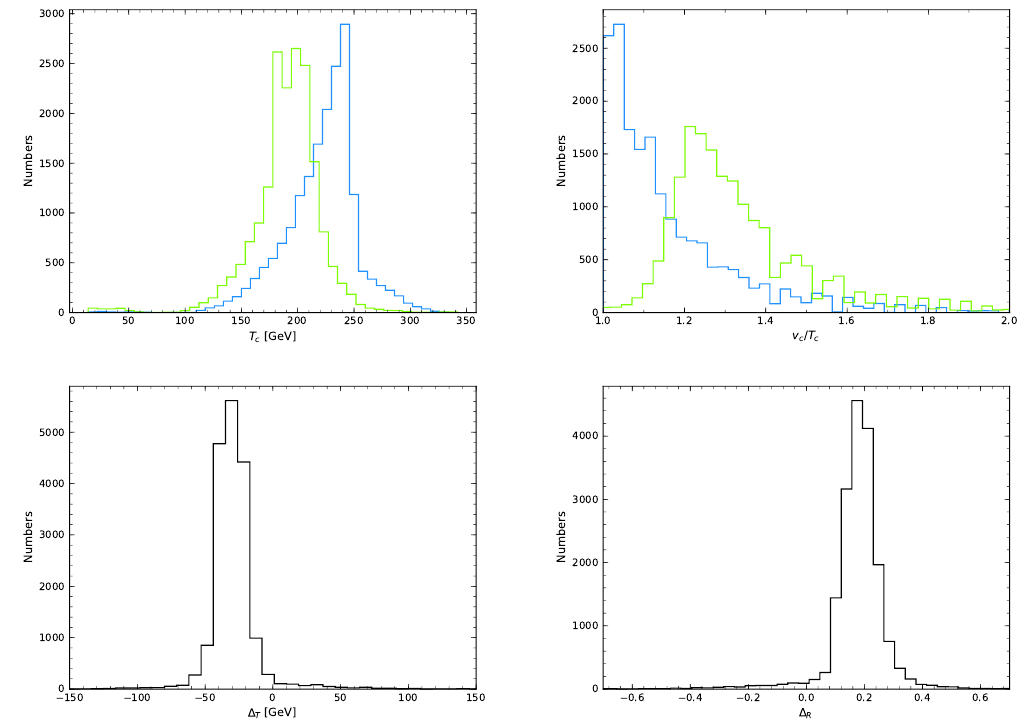
Figure 15 . Upper plots: distributions in T c and v c =T c in the Landau gauge potential (blue his- togram) and gauge-independent potential (green histogram). Lower plots: distribution of di(cid:11)erence between the gauge-independent potential and the Landau gauge potential in T c and v c =T c . The samples of input parameters are the same for both of the potential.